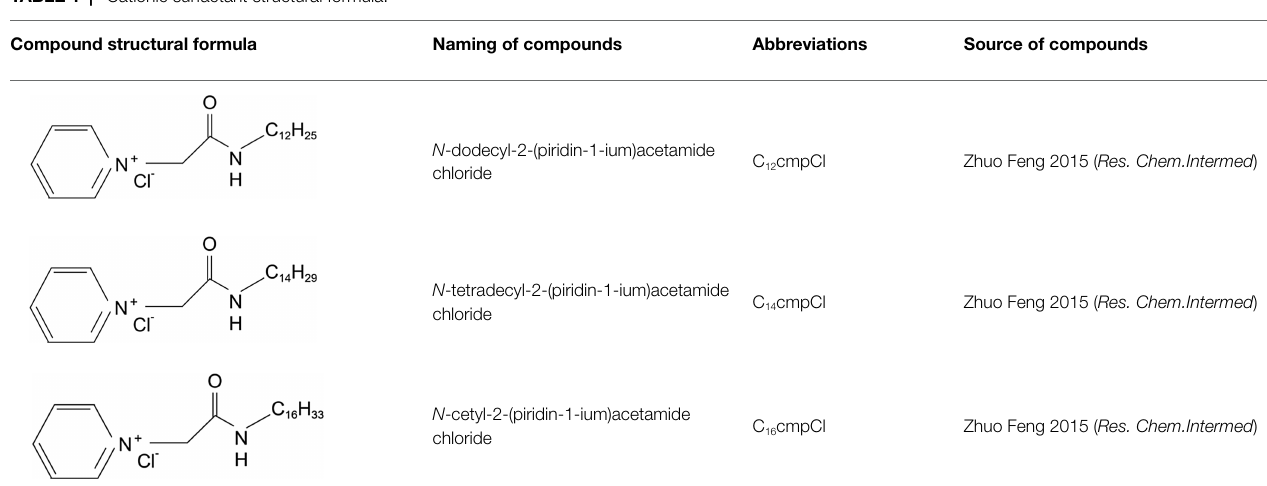
TABLE 1 | Cationic surfactant structural